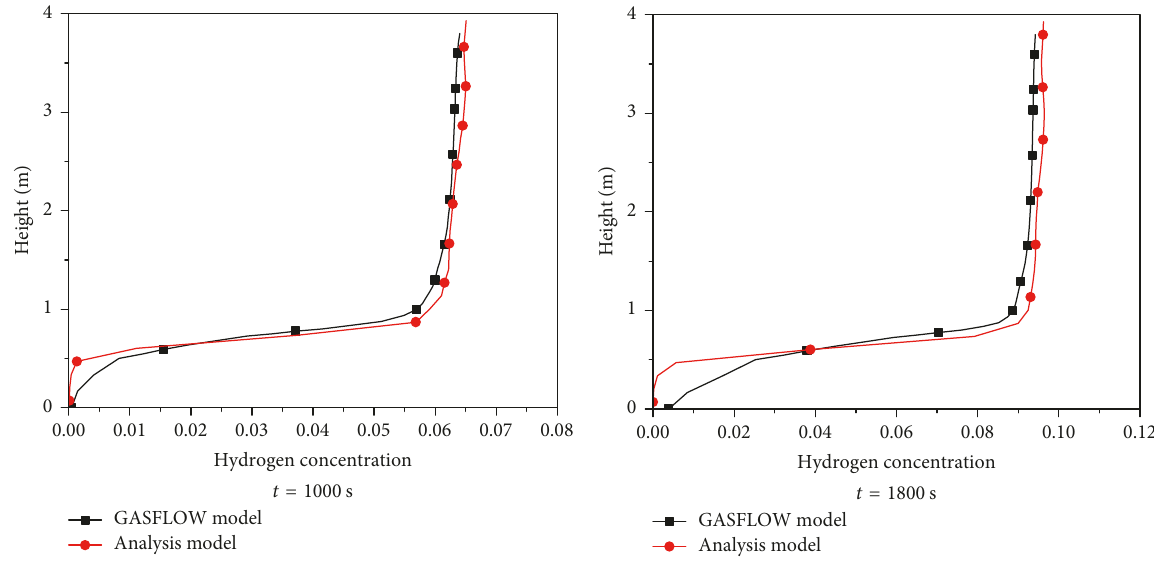
Figure 2: Hydrogen concentration distribution in source term